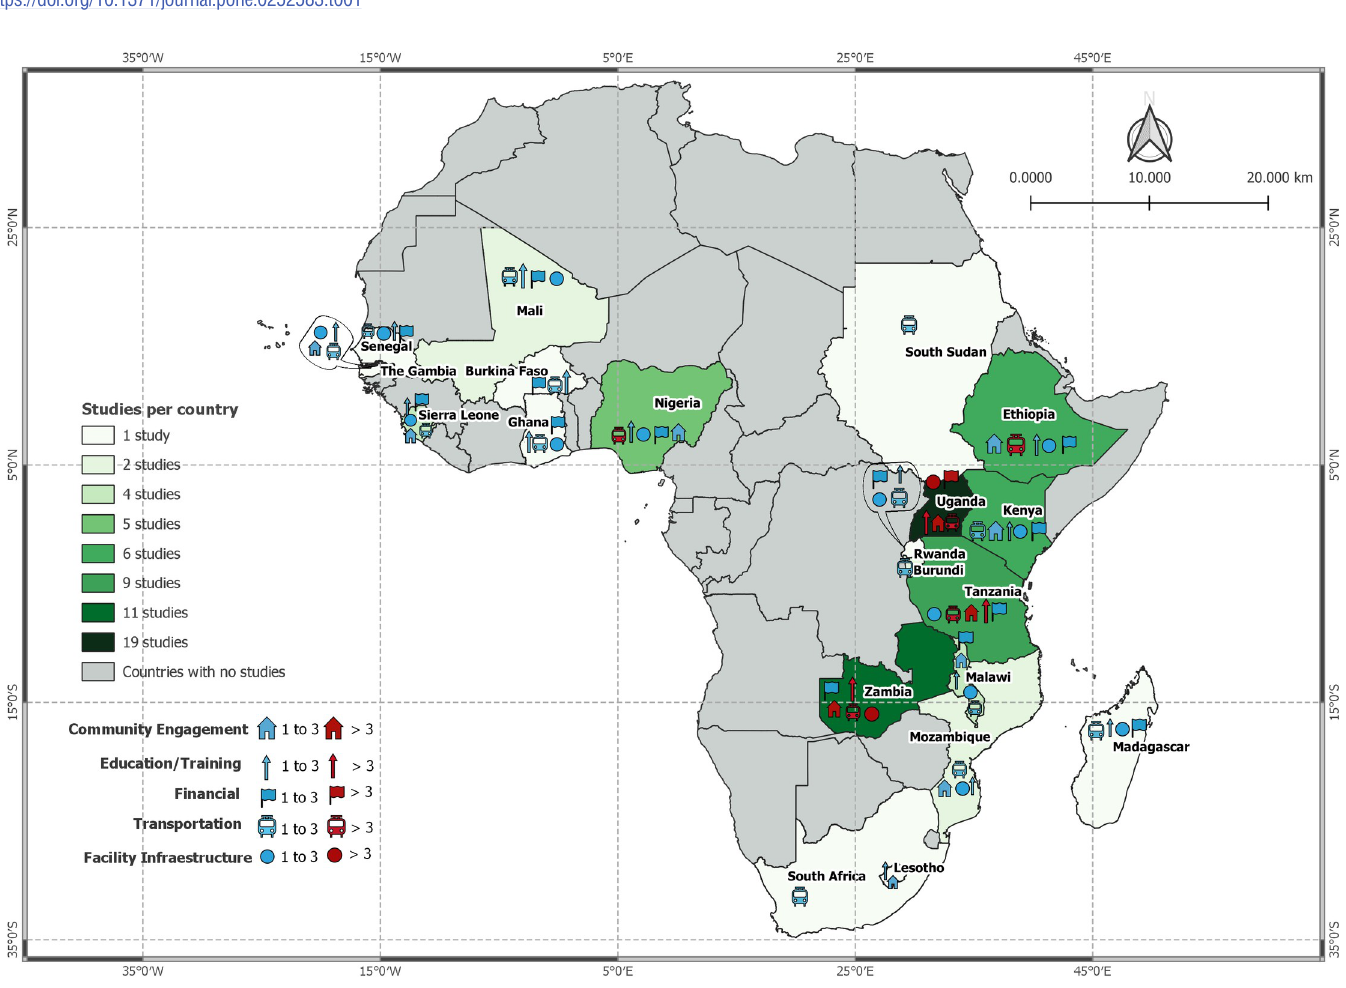
Fig 2. Geographic distribution of included